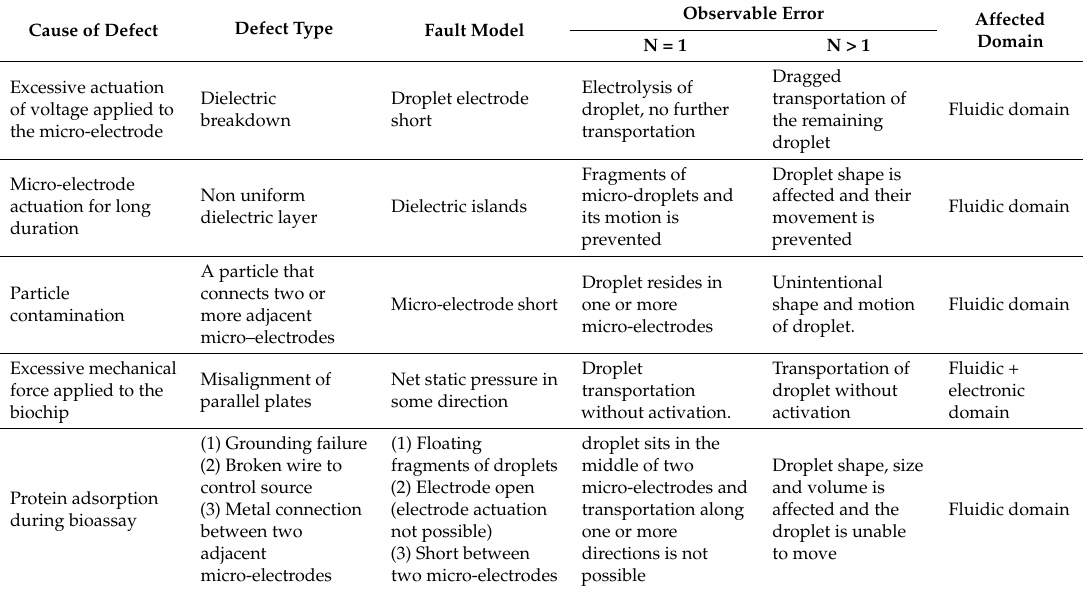
Table 2. Fault models for MEDA based